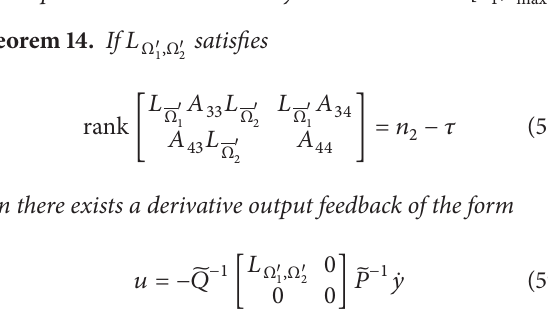
Figure 1: A circuit